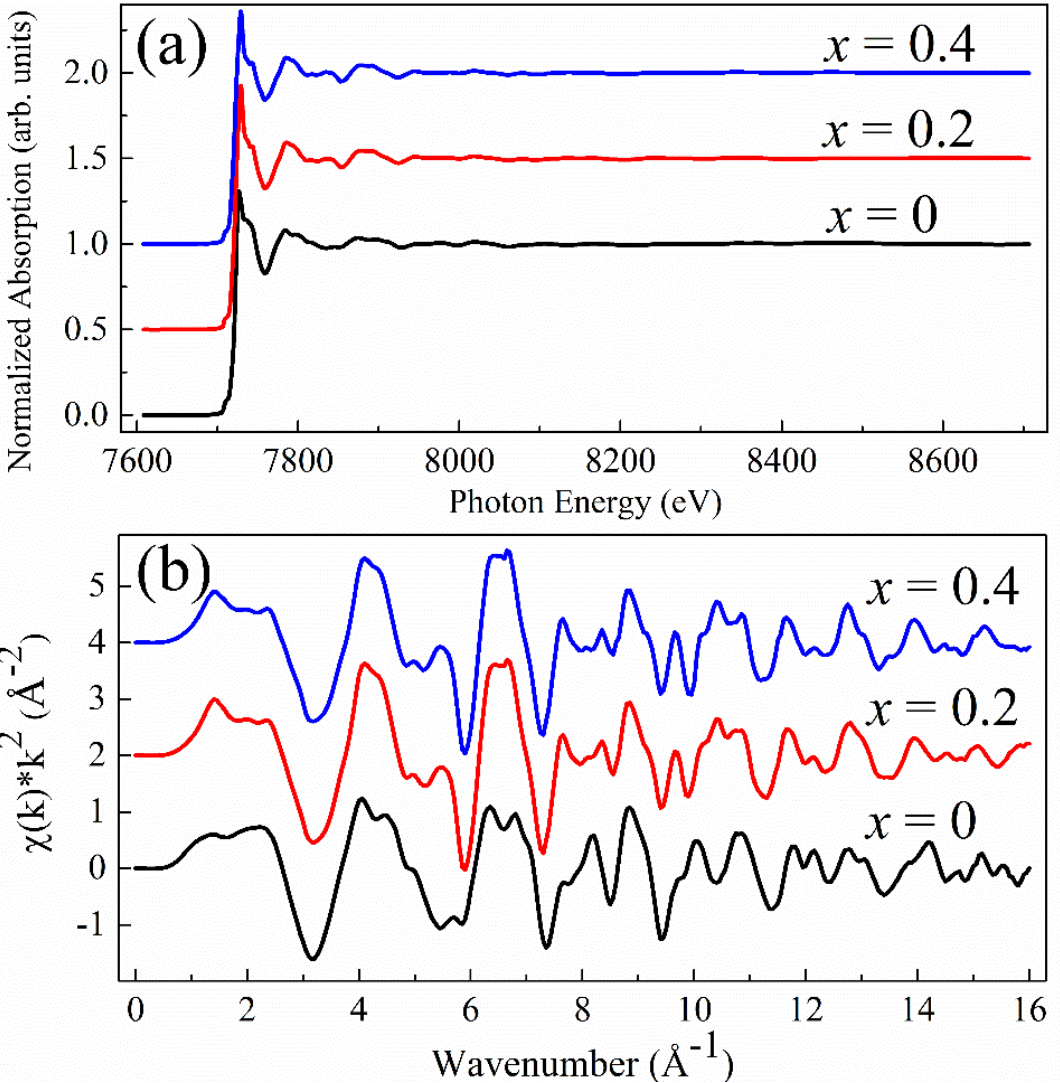
Figure 10. ( a ) Normalized absorption data measured at the Co K -edge of La 1 − x Ce x CoO 3 , where x = 0, 0.2, and 0.4. ( b ) Extracted k 2 -weighted χ ( k )